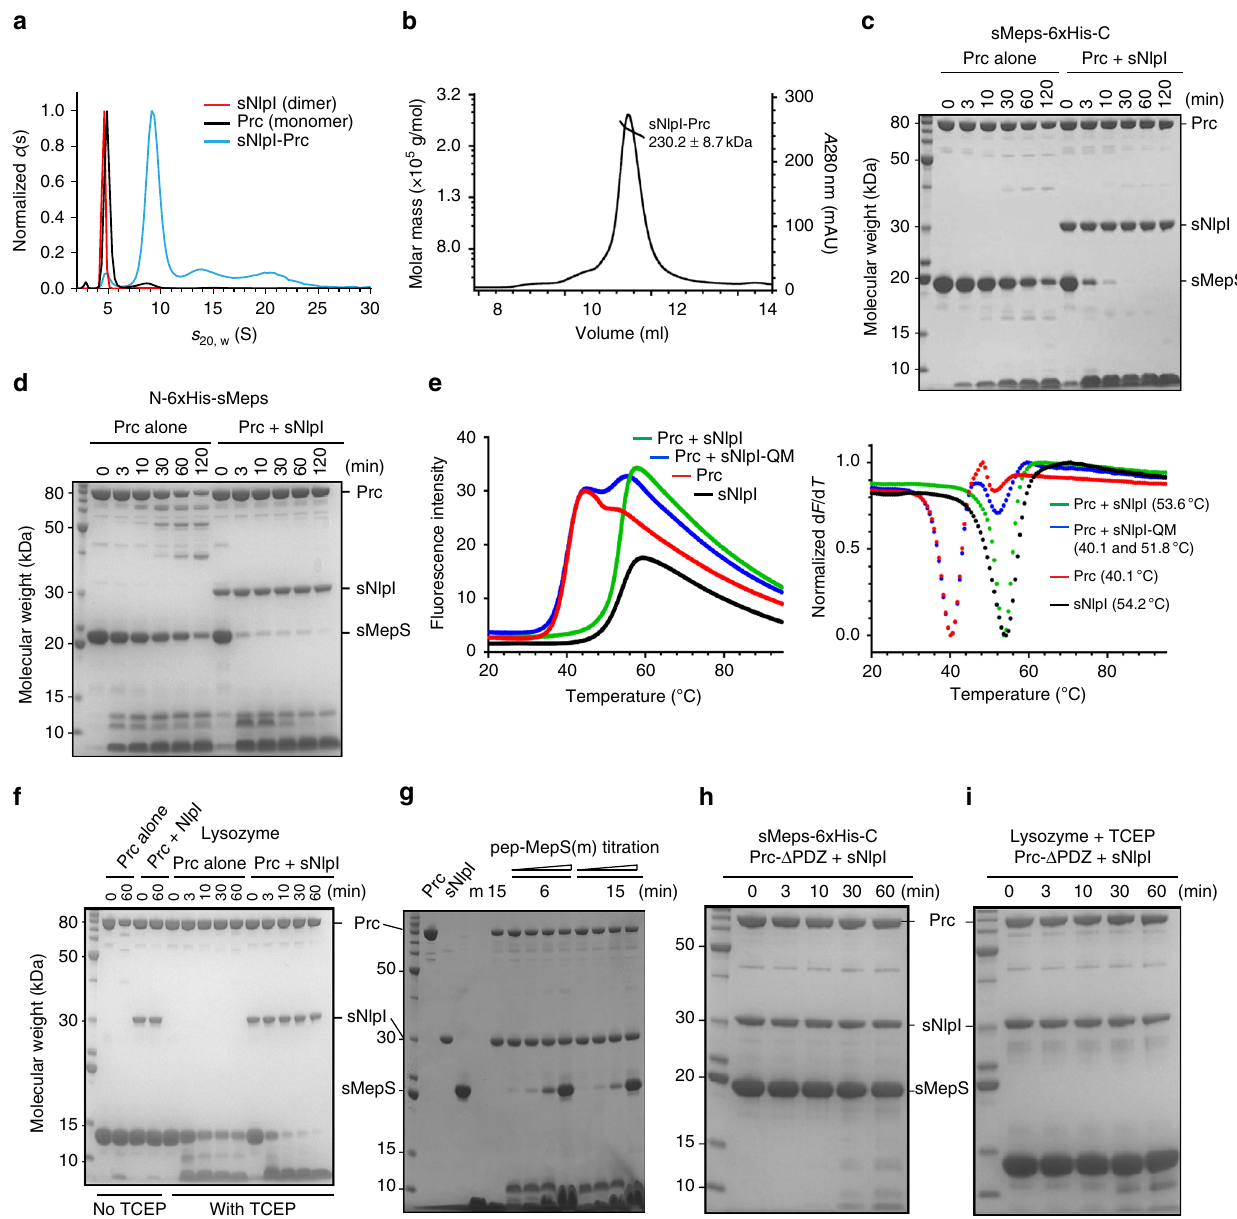
Fig. 1 NlpI forms a tetrameric complex with Prc and enhances Prc-mediated substrate degradation. a Sedimentation velocity pro fi les of sNlpI (4.7S), Prc (5.0S), and the sNlpI-Prc complex (9.4S). b SEC-MALS analysis of the sNlpI-Prc complex. UV curve is plotted with fi tted molecular weights. c and d Degradation of C- terminal c and N-terminal d 6×His-tagged sMepS (sMepS-6×His-C and N-6×His-sMepS, respectively) by Prc alone or with sNlpI, as monitored by SDS-PAGE assays. sMepS-6×His-C was used in all subsequent assays due to its superior stability. e Thermal shift melting curves (left) and their negative fi rst derivatives (right) of Prc alone and with wild-type NlpI or the binding de fi cient mutant NlpI-QM (see Fig. 5 below). Melting temperature ( T m ) values are shown within parentheses. f Degradation of native and 10 mM TCEP-treated denatured lysozyme by Prc alone or with sNlpI. g Degradation of sMepS by the sNlpI-Prc complex inhibited by increasing concentrations of the C-terminal peptide of MepS: NH 2 -RYNEARRVLSRS-COOH (m). h and i SDS-PAGE assays monitoring degradation of MepS h and denatured lysozyme i by Prc- Δ PDZ without the PDZ